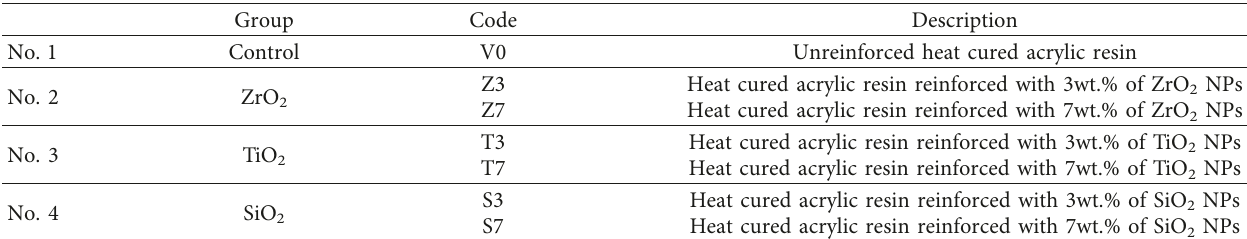
Figure 1: TEM and SEM representative images for nanoparticles utilized in the study, the average size of ZrO around 40 nm, 26 nm, and 16 nm, respectively. Table 2: Coding of different